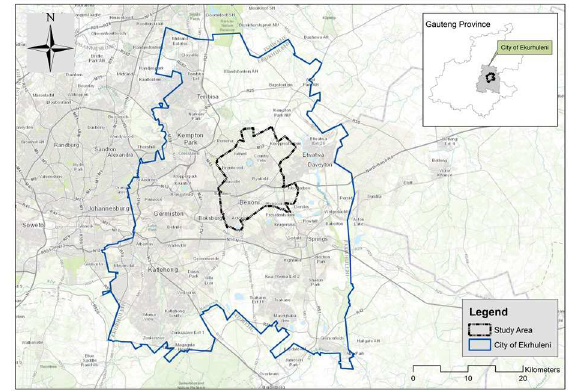
Figure 1: City of